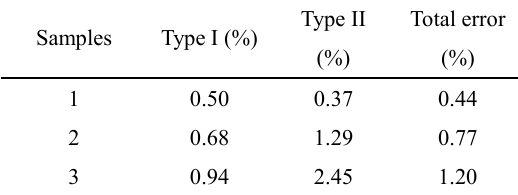
Table 3.Three types of error statistics